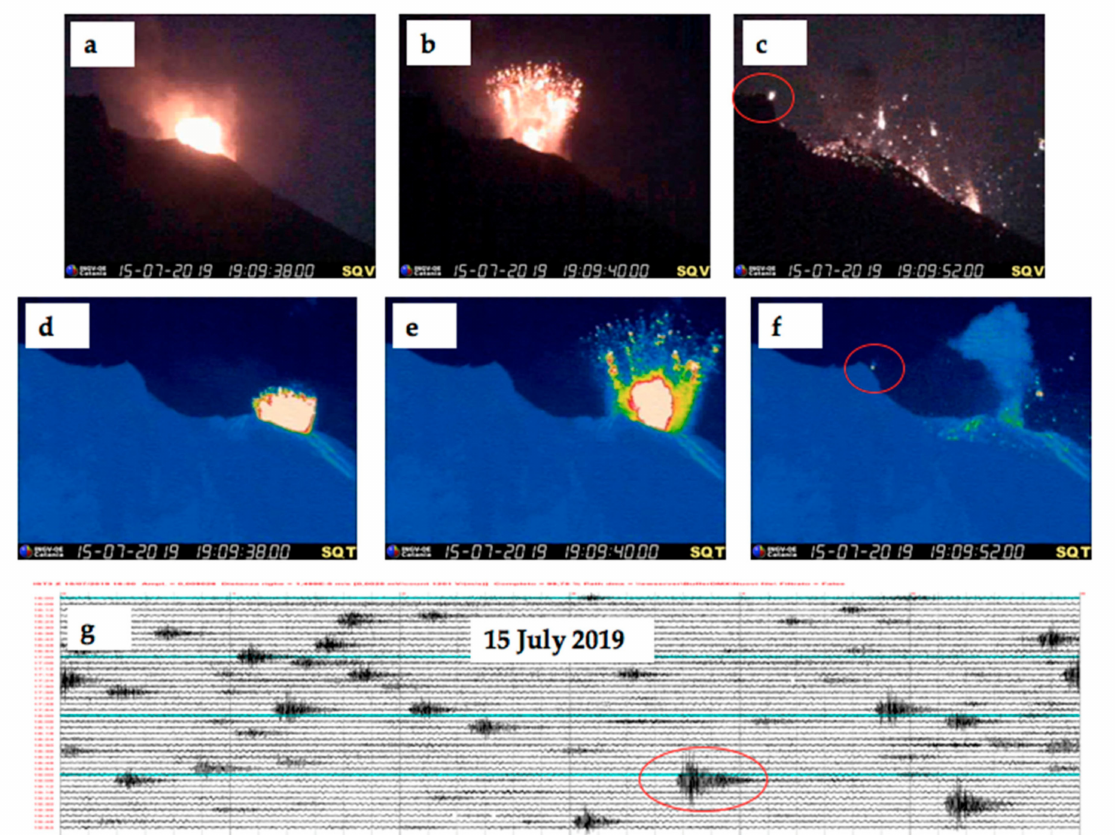
Figure 6. ( a – c ) Visual images from the SQV camera of the 15 July 2019 event at 19:09:38 ( a ), at 19:09:40 ( b ), and at 19:09:52 ( c ), view from NE. ( d – f ) Corresponding thermal images taken from the SQT camera, view from NE. Blue is cold, white is hot. The red circles in ( c ) and ( f ) indicate the incandescent block falling at Il Pizzo. ( g ) Seismic trace with the red ellipse evidencing the explosive event shown in the images above. See Figure 1 for station